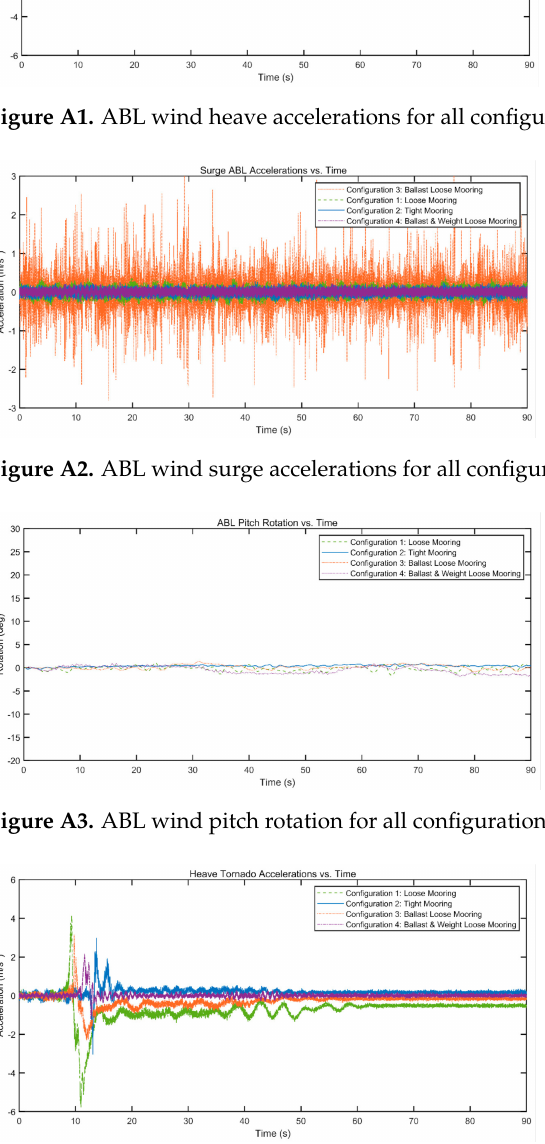
Figure A4. Tornado heave accelerations for all configurations.